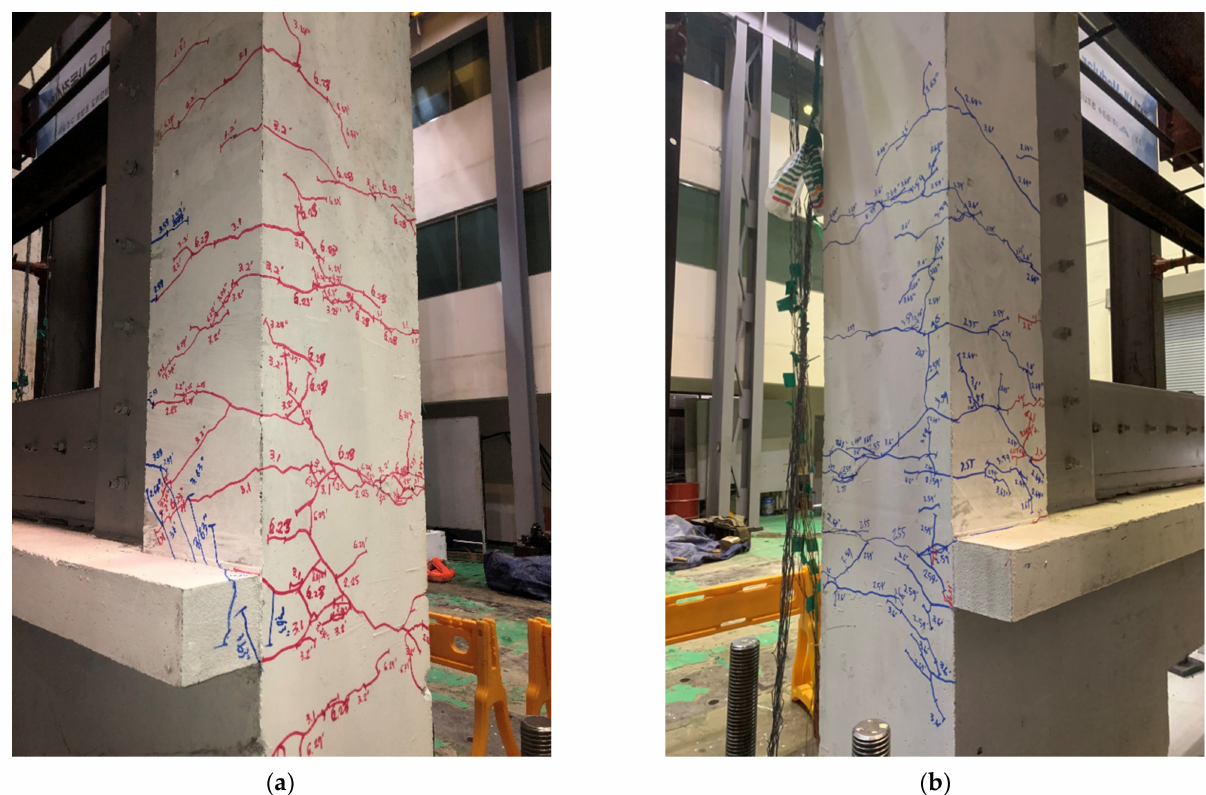
Figure 13. Cracks and ultimate state of test frame retrofitted with CFT-MF system (PD-CFT) (400 cm/s 2 )): ( a ) severe flexural and shear cracks of the right column and ( b ) severe flexural and shear cracks of the left column at around 3.63 s.